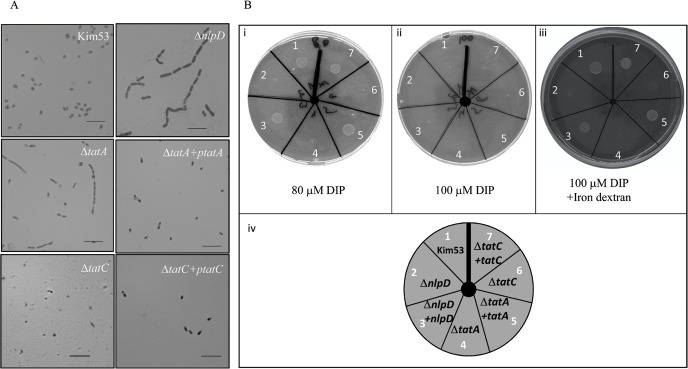
Phenotypic characterization of Y. pestis tat mutants.A. Gram staining of Y. pestis strains wild-type Kim53, ΔnlpD, ΔtatA, ΔtatC, ΔtatA+ptatA and, ΔtatC+ptatC was performed, and bacilli were observed by light microscopy at a magnification of ×1000. Scale bar = 10 μm. B. Growth of Y. pestis strains under iron-limiting conditions. Y. pestis strains (see description in the lower panel, iv), were grown under iron-limiting conditions (see Materials and Methods). The medium included: 1% agarose, 1× PMH2, 20 μM MgCl2 and 80 μM DIP (i), 100 μM DIP (ii) or 100 μM DIP with addition of iron dextran (0.5mg/ml, iii). The displayed data is one representative experiment.